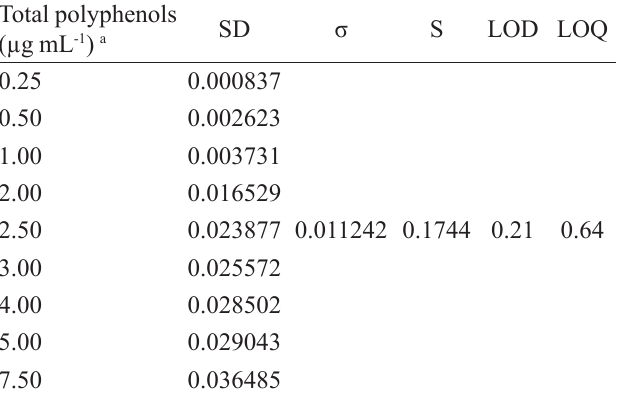
TaBLe V - Estimative of limits of detection and quantification from standard curve